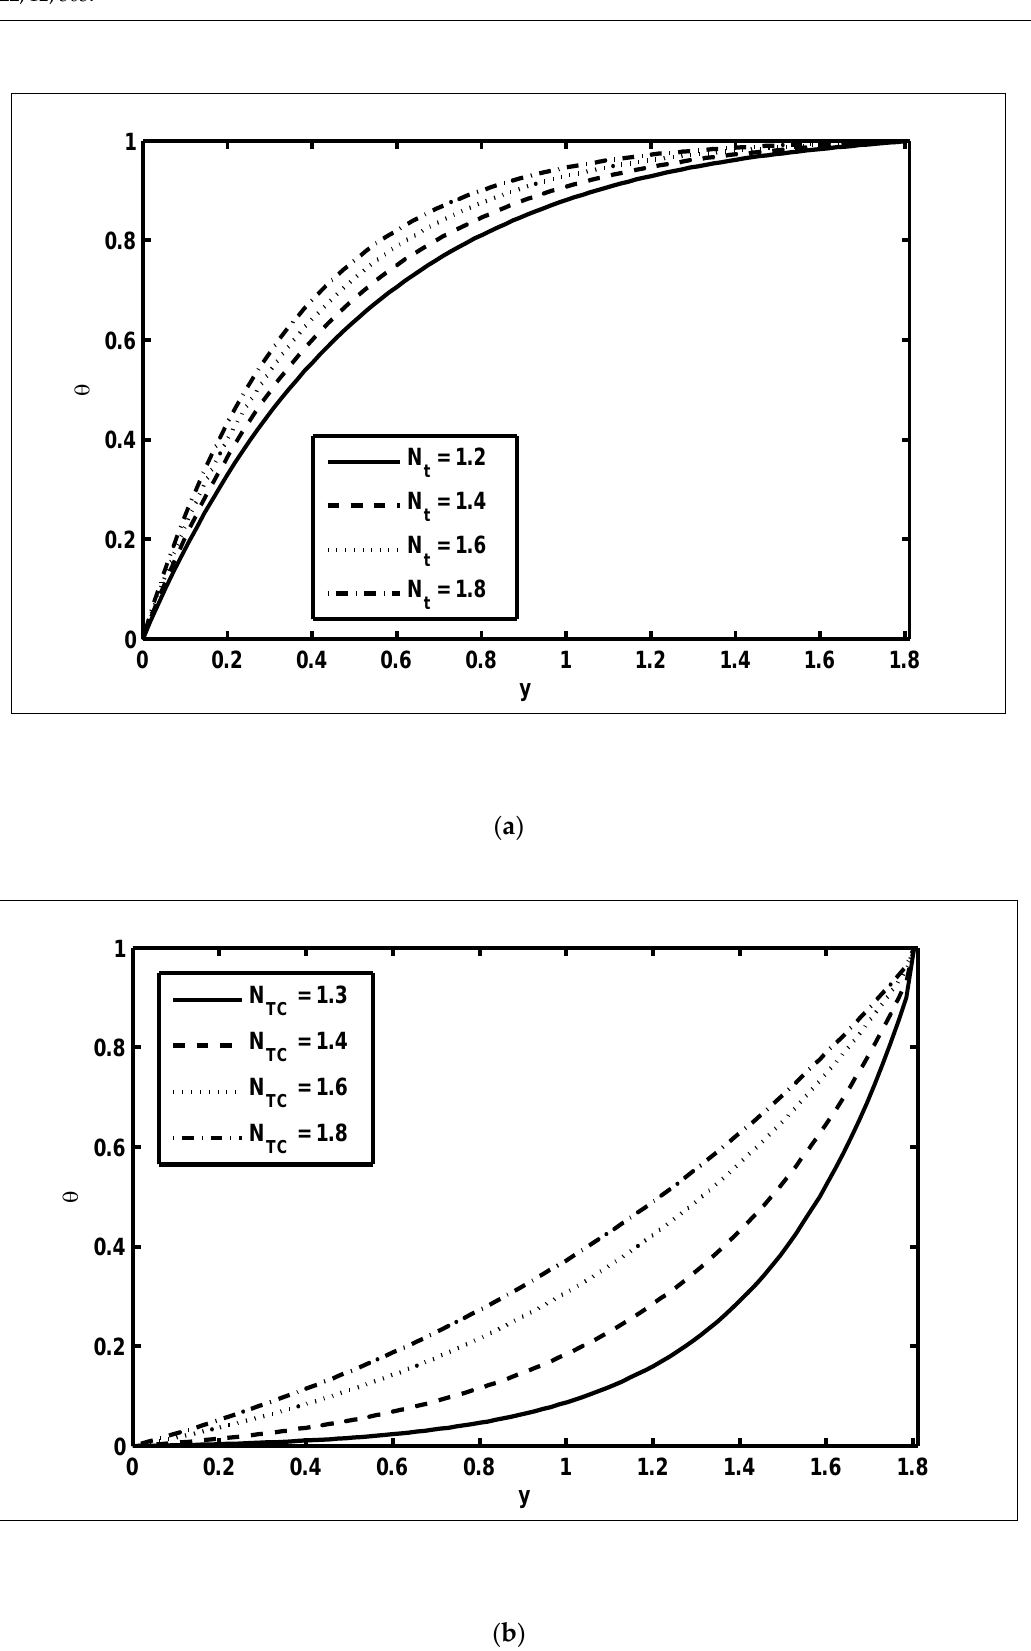
Figure 5. The temperature profiles ( 𝜃 ): ( a ) 𝑁 𝐶𝑇 = 0.9, 𝑁 𝑇𝐶 = 0.7, 𝑁 𝑏 = 0.9, 𝛽 = 0.4, 𝑚 = 0.2, 𝑥 = 0.2 ; ( b ) 𝑁 𝐶𝑇 = 0.9, 𝑁 𝑡 = 0.7, 𝑁 𝑏 = 0.9, 𝛽 = 0.4, 𝑚 = 0.2, 𝑥 = 0.2.